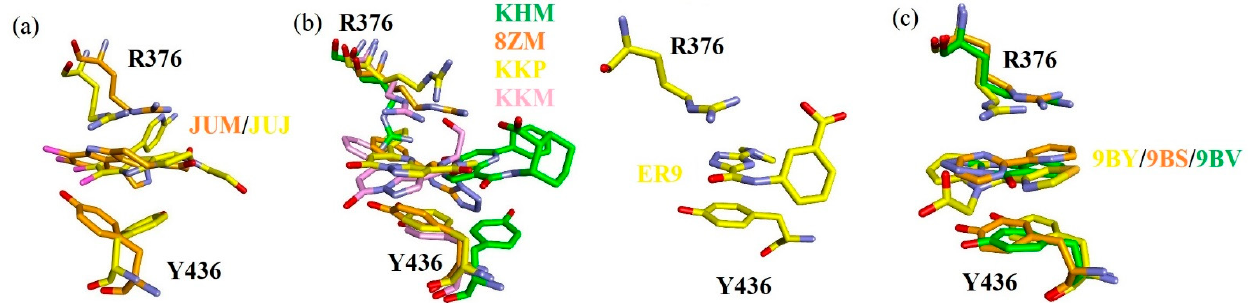
Figure 8. Superposition of sandwiched structures of the inhibitors ( a ) JUM and JUJ, ( b ) KHM, 8ZM, KKP, KKM, and ER9, and ( c ) 9BY, 9BS, and 9BV between the guanidinium group of R376 and the phenyl ring of Y436. Note that the C atoms of the inhibitors and associated proteins are shown in the same color.